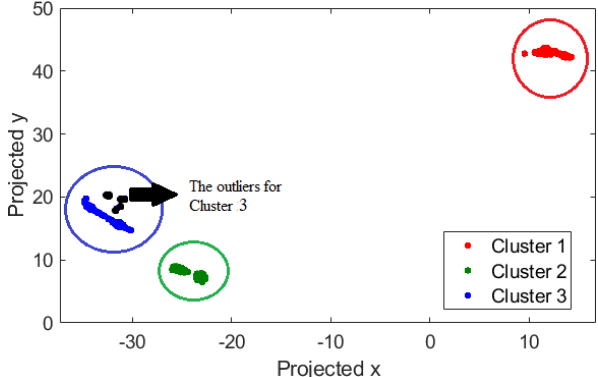
Figure 4. Clustering of lidar return signal type using the t -SNE al- gorithm for 339 profiles from the low-gain Rayleigh measurement channel on the night of 15 May 2012. The profiles are automati- cally clustered into three different groups selected by the algorithm. Cluster 3 has some